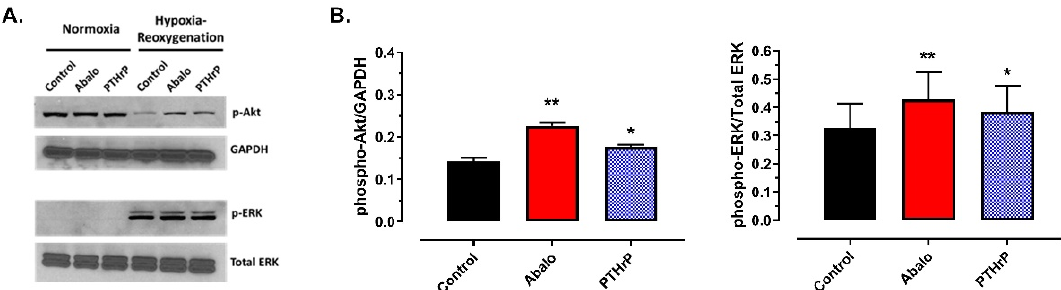
Figure 2. Effect of PTHrP(1-36) (PTHrP) and abaloparatide (Abalo) on phospho-Akt and phospho- ERK expression in HL-1 cells subjected to simulated ischemia-reperfusion. ( A ) original immunoblots; ( B ) Mean phospho-Akt expression (normalized to GAPDH), mean phospho-ERK expression (normalized to total ERK) ± SEM. * p < 0.05, ** p < 0.01 versus control group.